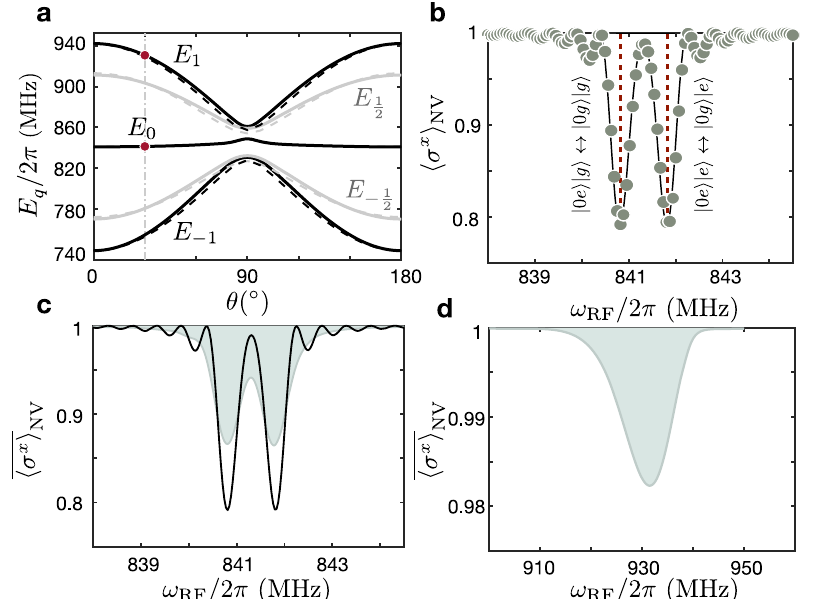
Fig. 2 Energy branches of the spin labels and associated spectra. a Energy-transition branches of an electron spin label at B z = 30 mT for 14 N ( 15 N). Solid black (gray) lines show the transition energies as a function of the azimuth θ obtained via numerical diagonalization of Eq. (2). Dashed black (gray) lines correspond to E 1,0, − 1 in Eq. (3) [ E 1/2, − 1/2 in Eq. (4)]. The vertical line highlights the case θ i = 30°, with red dots as a function of the RF frequency applied near E 1 . The indicating the transition energies relevant in the following plots. b NV spectrum h σ x i 0 NV J z given by Eq. (2) (black line) and by E i (gray circles). The fi rst nitroxide has spectrum was obtained by unitary propagation of Eq. (1) with H n 0 i i azimuth θ 1 = 30° while the second nitroxide has azimuth θ 2 = 91.7°. The splitting of the peaks is induced by the inter-label coupling g 12 ≈ 2 π × 1 MHz. The positions of the resonances are indicated by the dashed red lines. In ( c , d ), shaded areas show the average NV spectra h σ x i in the presence of tumbling of the fi rst (near-resonant) nitroxide. Tumbling was mimicked by averaging over a random azimuth NV following a Gaussian distribution centered at the equilibrium value θ 1,eq = 30°. The orientation of the other nitroxide was kept fi xed for simplicity. The standard deviation was chosen to be σ θ = 6.25°. In ( c ), we observe that tumbling leads to a loss of contrast and to signal broadening near E 1 . Nevertheless, the spectrum still shows two clearly separated peaks. For comparison, the case without tumbling in ( b ) is 0 near E 1 . Here, the energy splitting cannot be resolved due to nitroxide tumbling. superimposed (black line). d Average NV spectrum h σ x i NV 1 Also note that tumbling severely reduces contrast. For that reason, the spectrum in the absence of tumbling has much higher contrast and is not